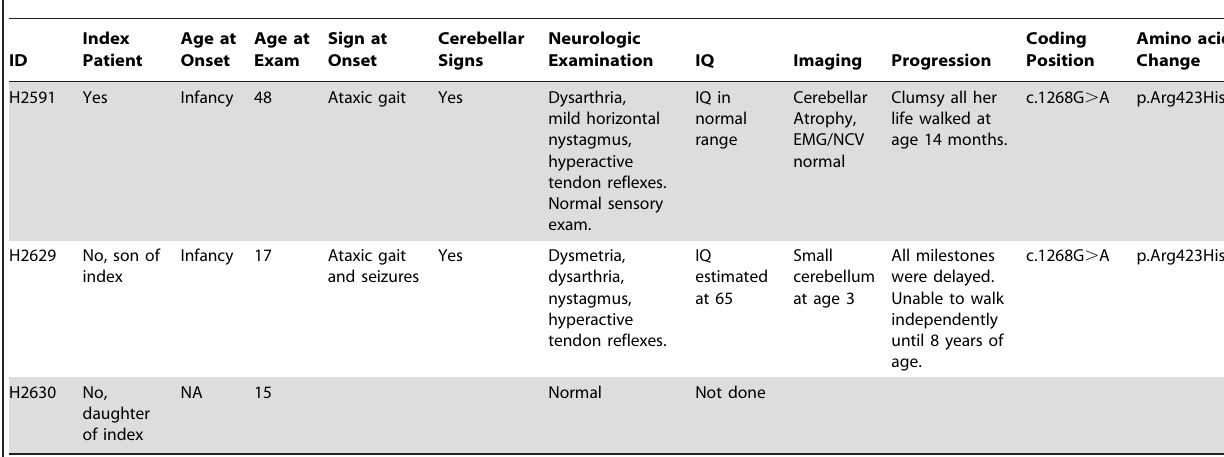
Table 2. Clinical and mutation findings of p.Arg423His index patient and relatives.